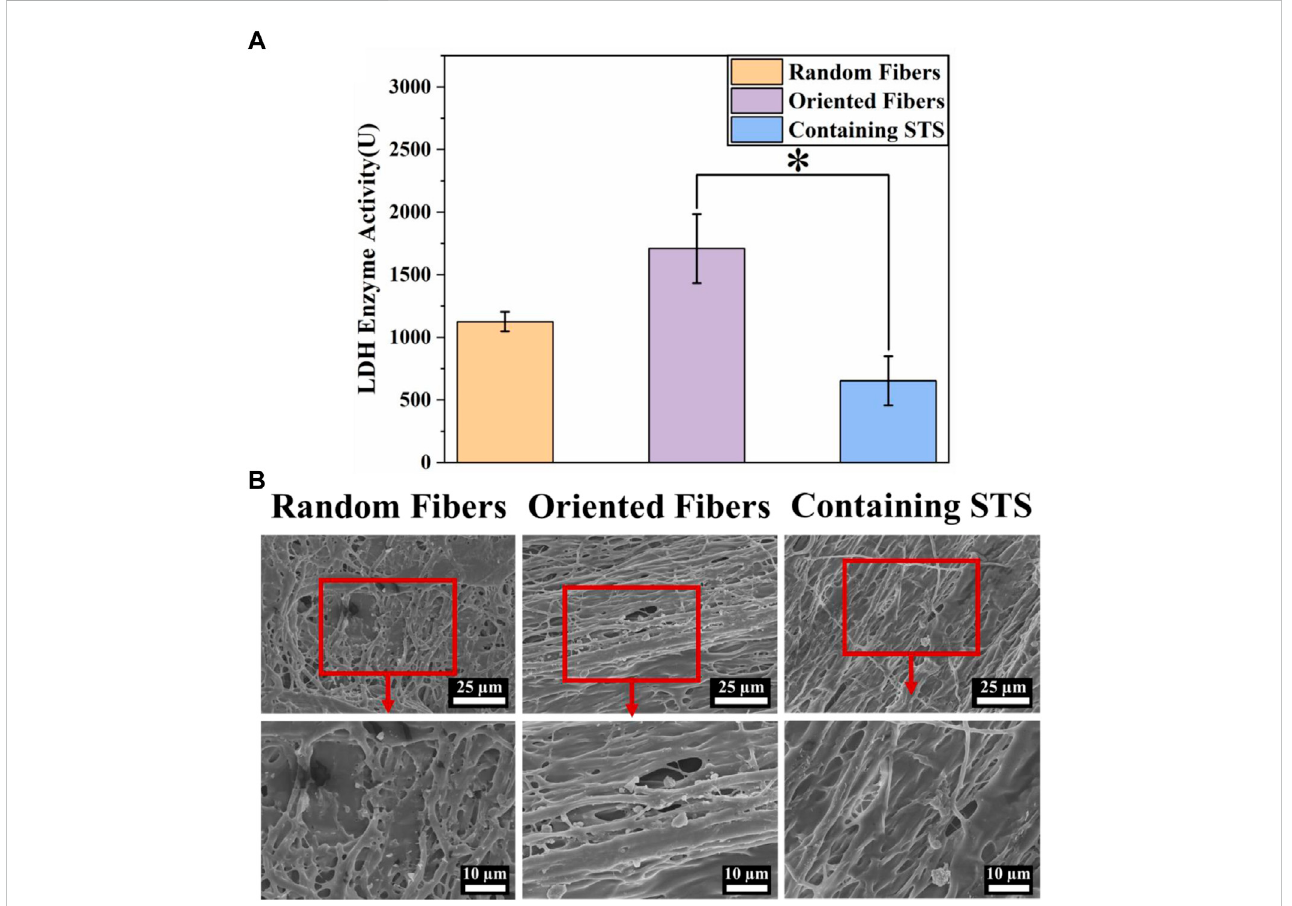
FIGURE 5 Hemocompatibility of fi ber membranes. (A) LDH activities of random- fi ber membranes, oriented- fi ber membranes, and oriented- fi ber membranes containing STS (N = 3, * p < .05). (B) Platelet adhesion on random- fi ber membranes, oriented- fi ber membranes, and oriented- fi ber membranes containing